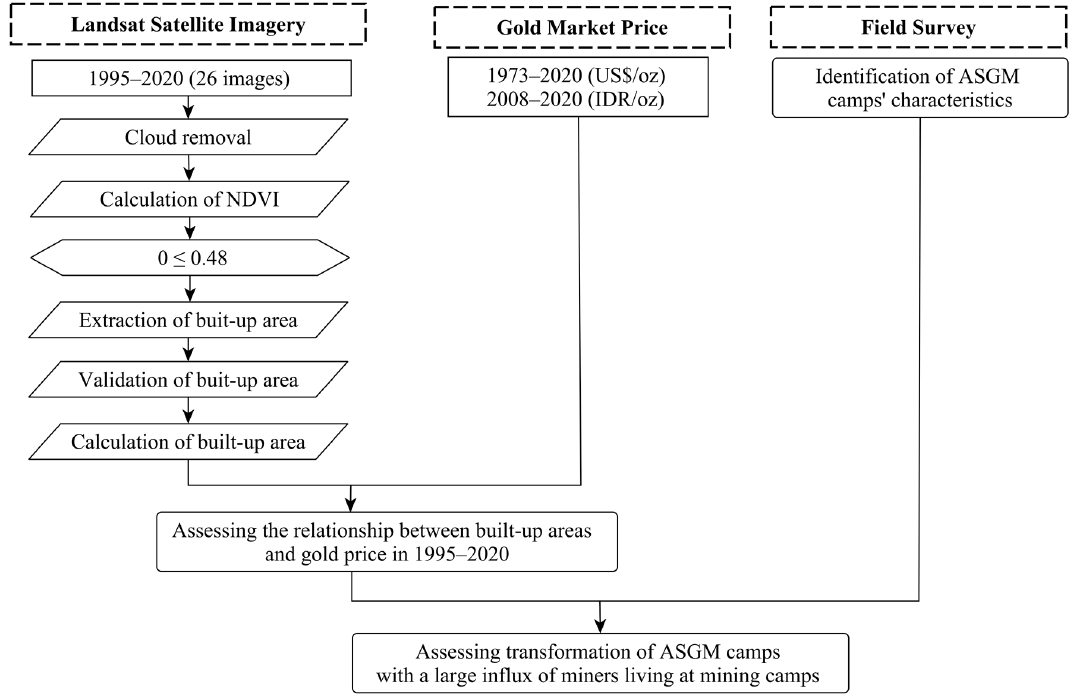
Figure 1. Overall